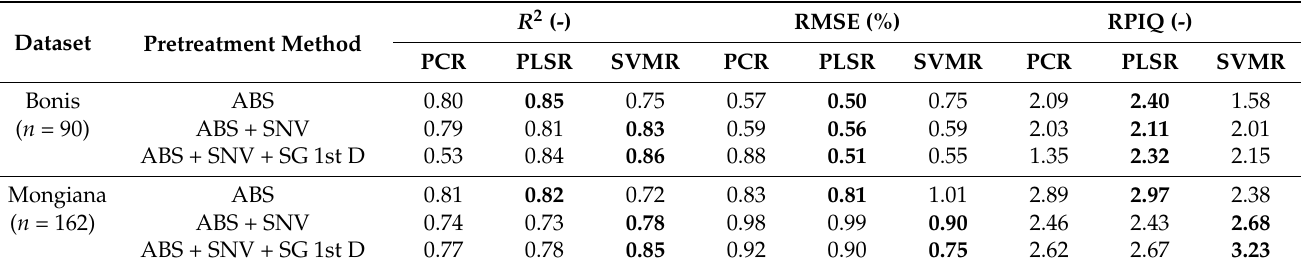
Table 2. Performance of the calibration models obtained by PCR, PLSR, and SVMR, coupled with different spectroscopic pretreatment techniques for SOC prediction at the two study areas. The best results of the models are highlighted in bold.